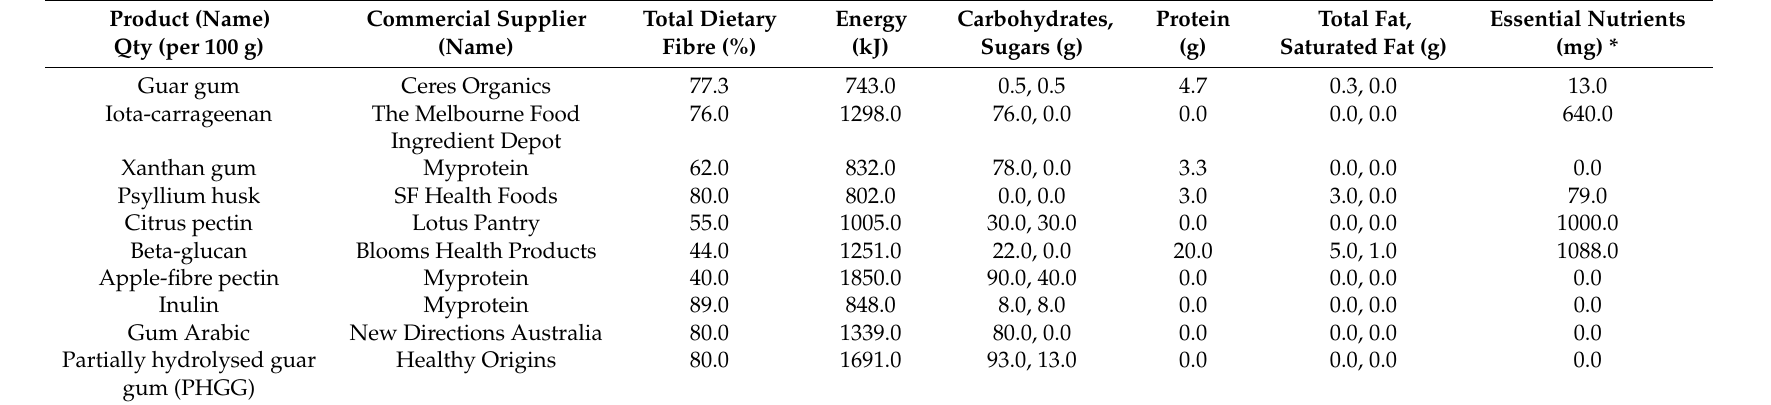
Table 1. Labelled nutritional content of tested dietary fibre